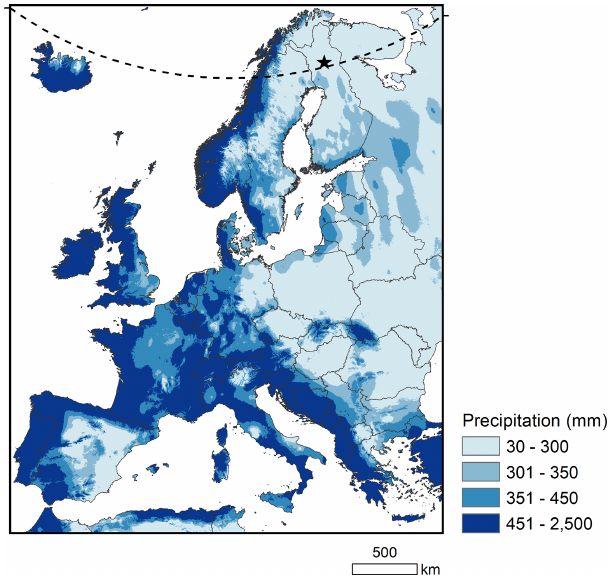
Figure 1. Overview of the geographical location of the experi- ment setup in Sodankylä, Finland (black star), which is just above the Arctic Circle (dashed line). The average 7-month total pre- cipitation (in mm) for the colder months per year (January–April and October–December) in the period 1970–2000 are shown in the map derived from the monthly climate data from WorldClim (see also https://www.worldclim.org/data/worldclim21.html, last access: 31 January 2022, Fick and Hijmans,